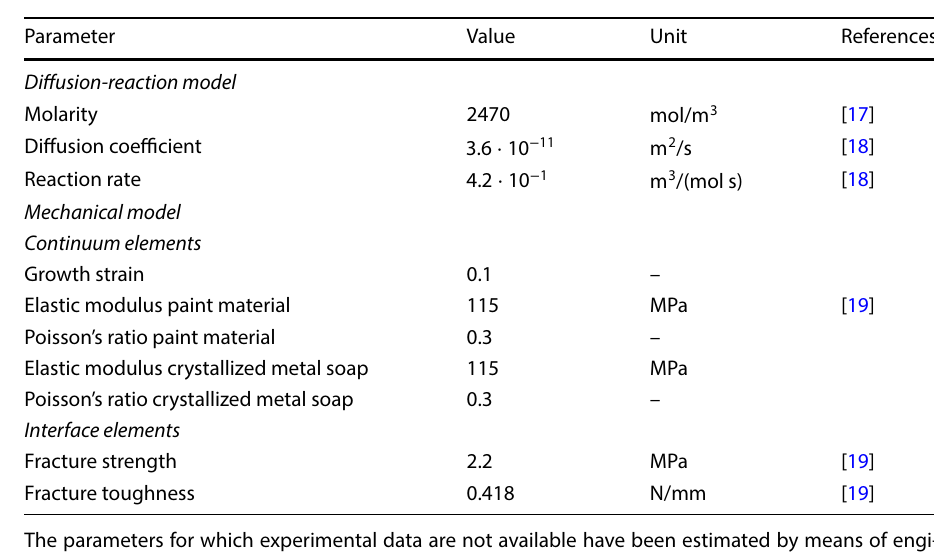
Fig. 3 a Reference model used in the numerical analyses. b , c Input models for the param- eter variation study exploring the effect of b the aspect ratio of the initial metal soap nucleus and c the saturated fatty acid concentration profile at the right domain